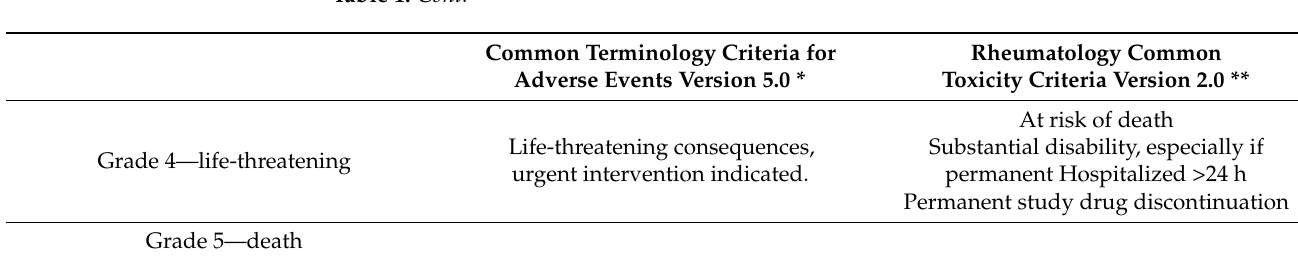
Table 1 references: *—[33];